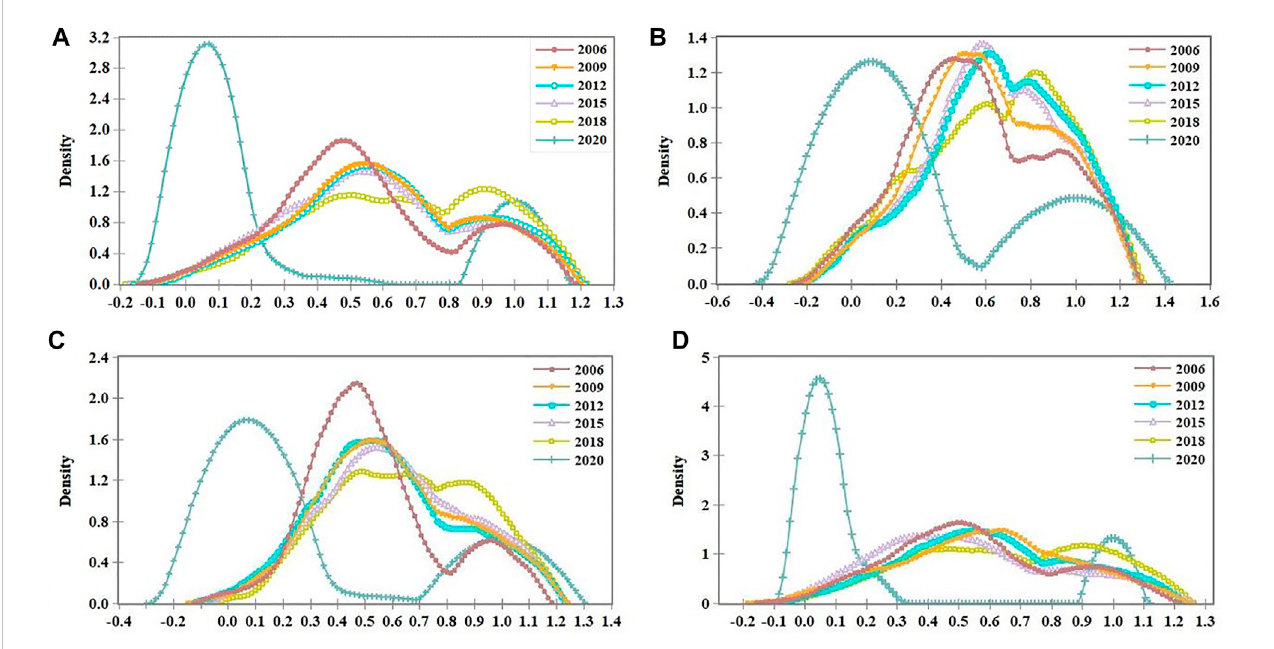
FIGURE 3 Kernel density distribution of ULUE in the YREB, (A) The whole YREB, (B) The upstream area, (C) The midstream area, (D) The downstream